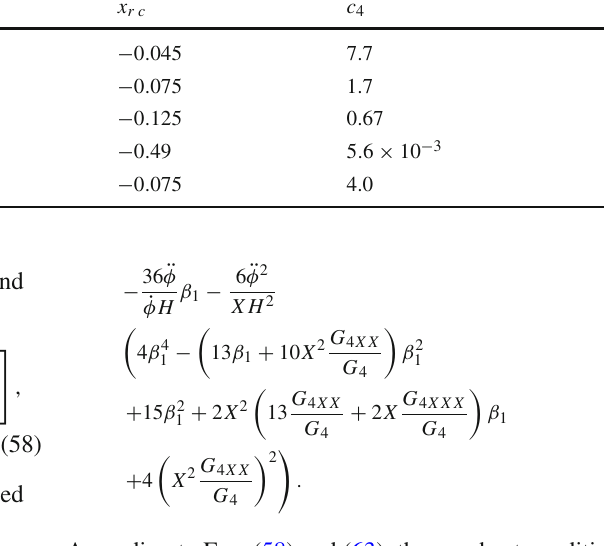
Table 1 The models used in the plots. We set (cid:10) mc = 0 . 95 for models I–IV and (cid:10) mc = 0 . 93 for model V. The column w eff shows the value of w eff at the field-dominated point